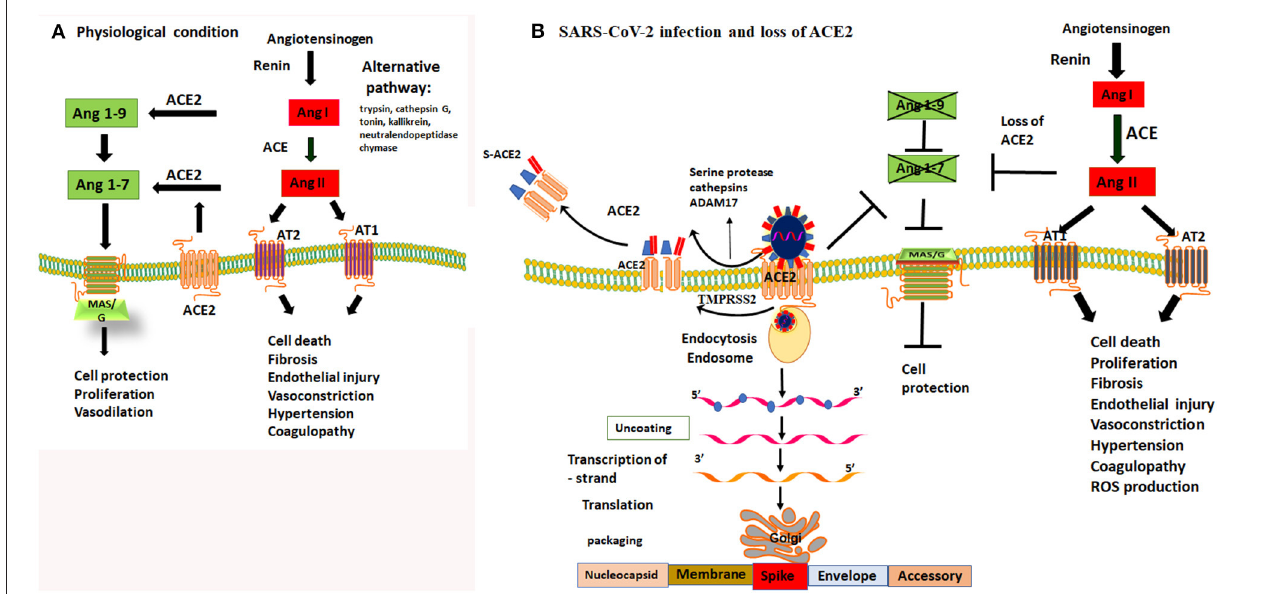
FIGURE 1 | Dysregulation of Ang II and Ang (1-7) by loss of protective function of ACE2 receptor. (A) under physiological condition there is a balance in ACE and ACE2 receptor activity. ACE regulates the Renin Angiotensin Aldosterone system (RAS) and cleaves Ang I to produce Ang II. Ang II is a potent vasoconstrictor and detrimental for endothelial and epithelial function through activating AT1 and AT2 receptors. The counterbalance of the RAS/Ang II output is regulated by ACE2 and Mas/G protein coupled receptor activity. ACE2 cleaves Ang I and Ang II into Ang-1-9 and Ang1-7, respectively, thereby it activates MAS/G protein coupled receptor that protect cell death. (B) SARS-CoV-2 binds to ACE2 to gain entry to epithelial cells of the lungs. Cleavage of spike proteins by a protease such as trypsin/cathepsin G and or ADAM17 on ectodomain and TMPRSS2 of endodomain sites facilitate viral entry into the cells. This process leads to shedding of host ACE2 receptors and loss of its protective function. Loss of function of ACE2 activity prevents production of Ang 1-9 and Ang1-7. Lack of Ang1-7 diminishes the activity of MAS/G receptor, leading to the loss of its protective functions including vasodilatation, cell protection both at the epithelial and endothelial sites. Loss of ACE2 function leads to an imbalance and unchecked effects of Ang II and upregulation of RAS/Ang II pathway. Upregulation of Ang II leads to vasoconstriction, thrombophilia, microthrombosis, alveolar epithelial injury and respiratory failure. Therefore, inhibiting the proteolytic function of trypsin/cathepsin and ADAM17 or TMPRSS2 and or direct activation of MAS/G receptor by enhancing Ang-(1-7) can overcome the loss of function ACE2 and are viable targets to prevent tissue damage to the